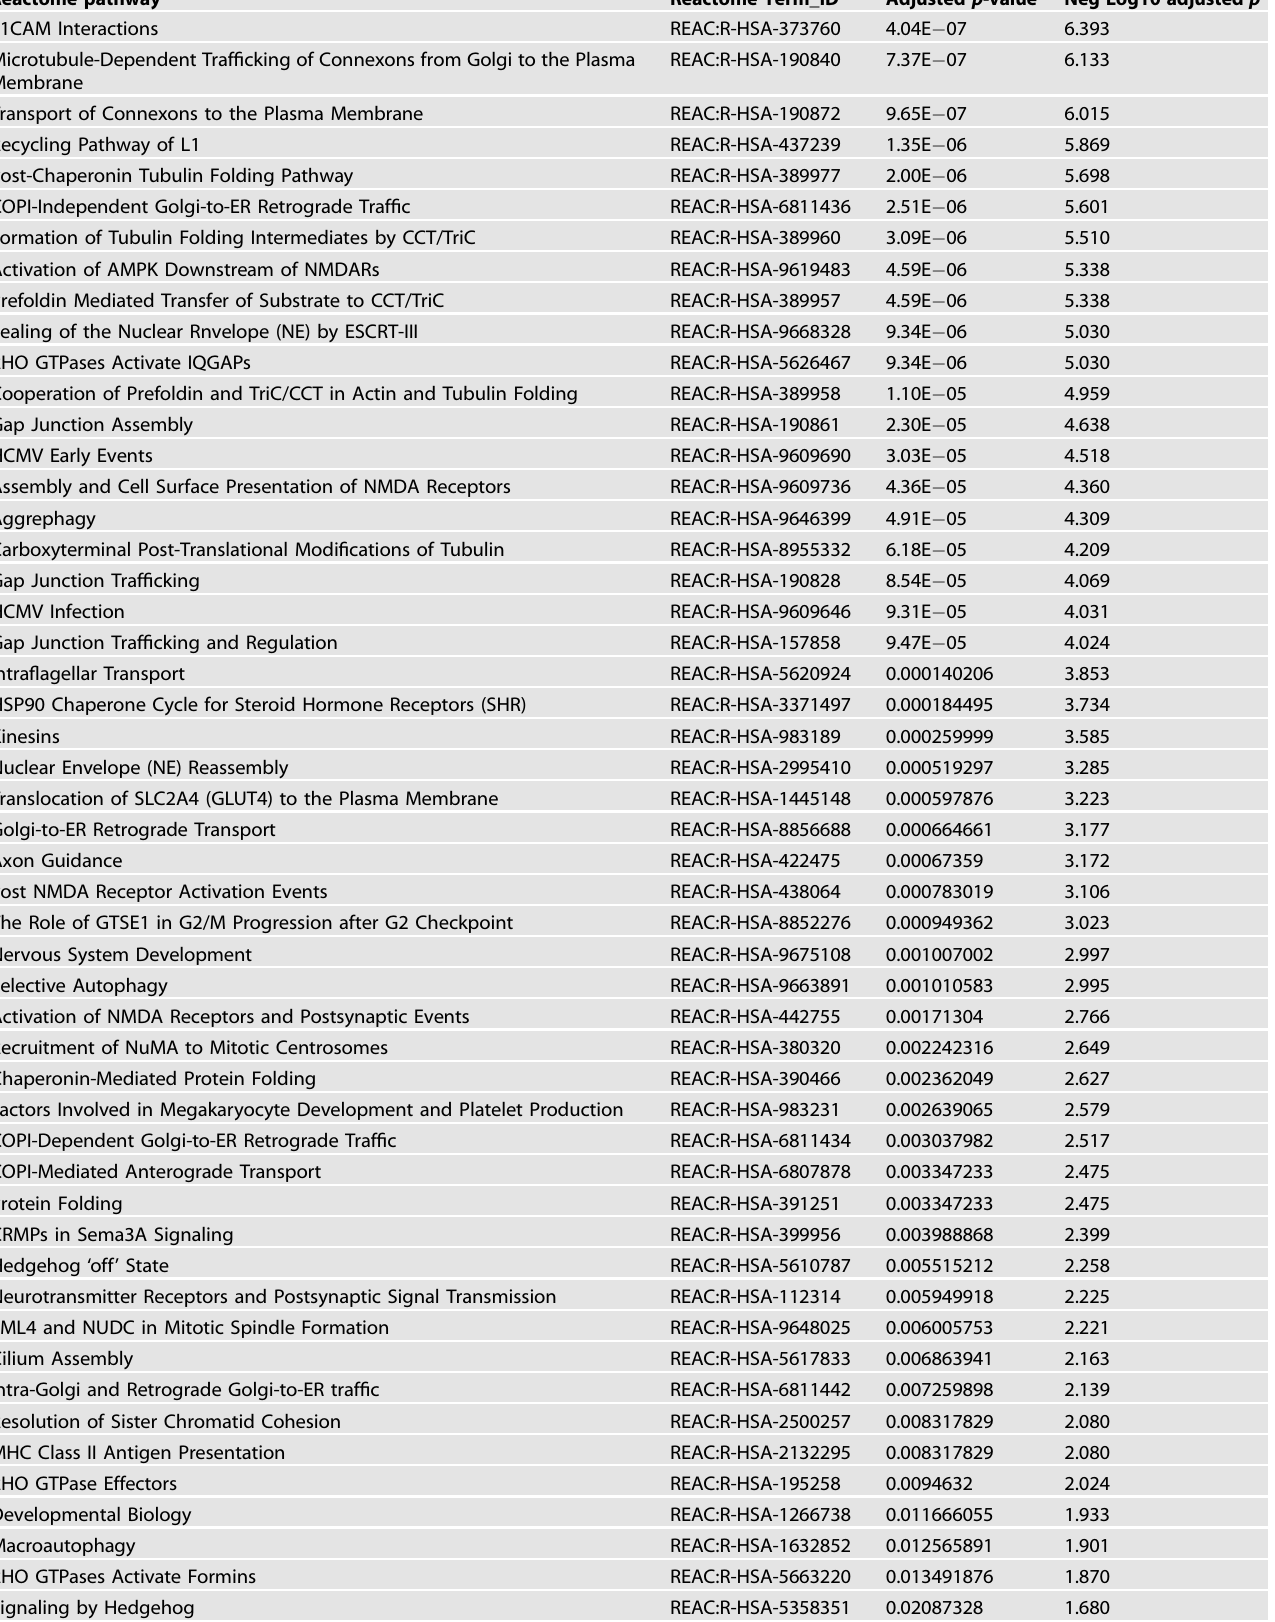
Table 7. Down-regulated reactome pathways in Scz organoids ( p <